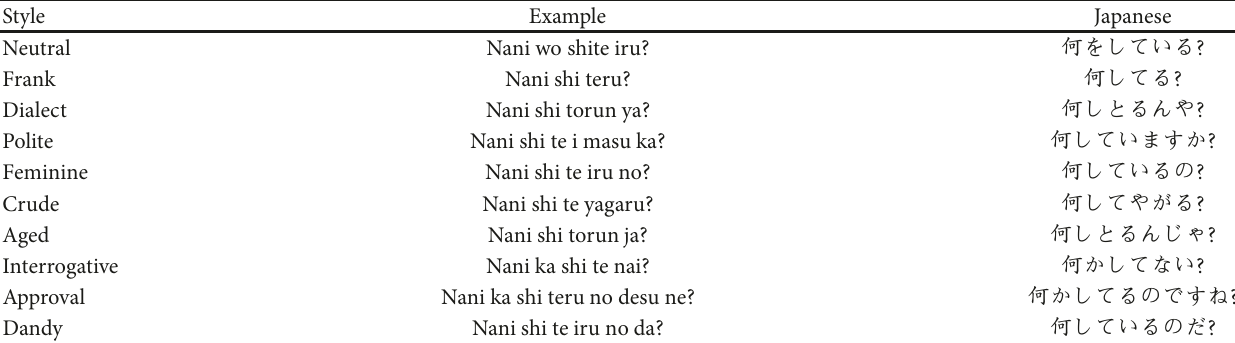
Table 6: Examples of each utterance